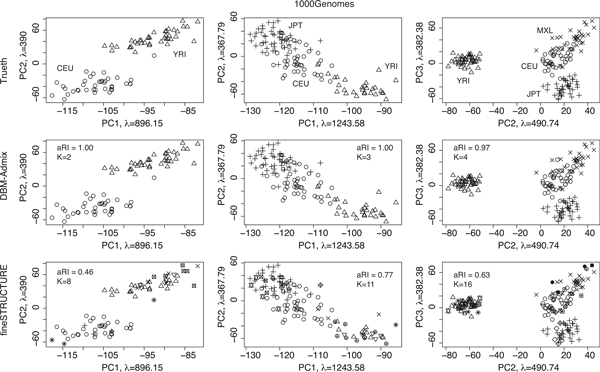
Comparison of de novo structure inference in 1000Genome data. Each plot shows individuals (haplotypes) in different origins (shown in symbols) projected onto the principal components (λ denotes eigen values). Top: true origins. Middle: origins inferred by DBM-Admix. Bottom: origins inferred by fineSTRUCTURE. Columns from left to right correspond to datasets containing 2, 3 and 4 populations, respectively. aRI: adjusted rand index. K: estimated number of populations.